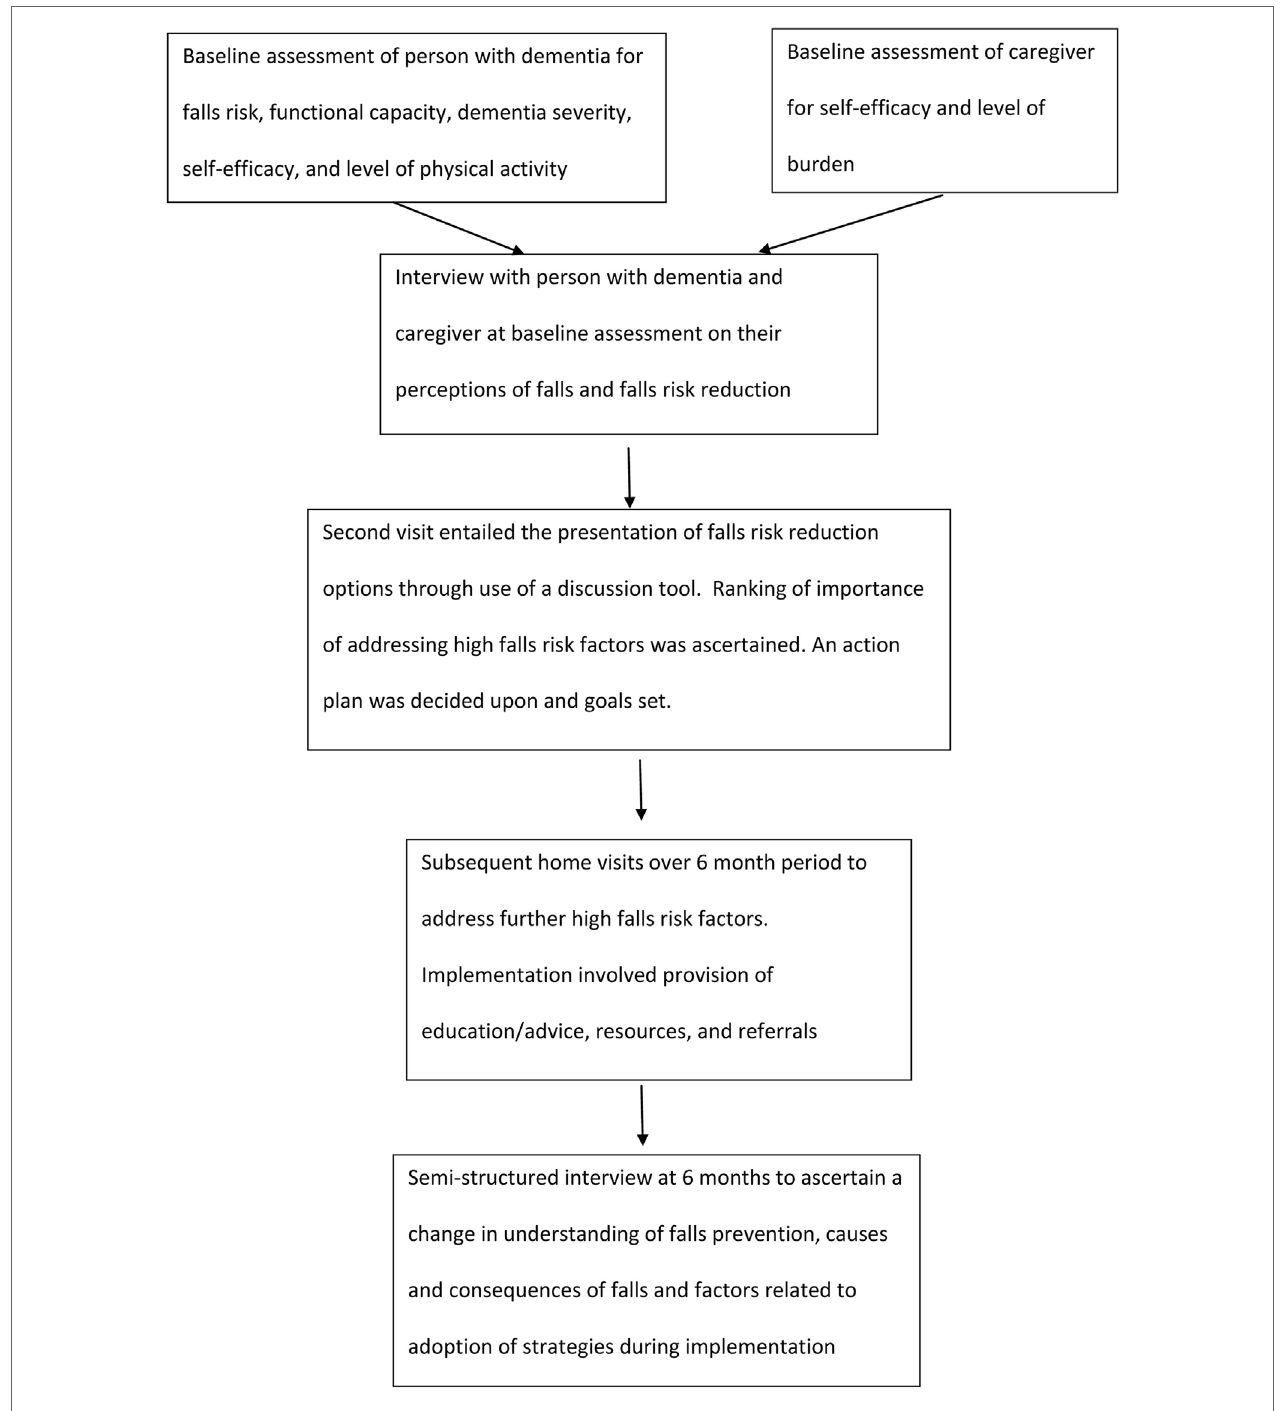
FigUre 1 | implementation of 6-month intervention